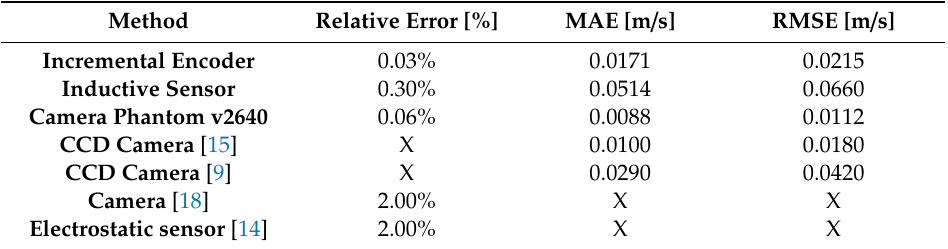
Table 2. Compared accuracies of selected linear speed measurement methods; X—no data available.